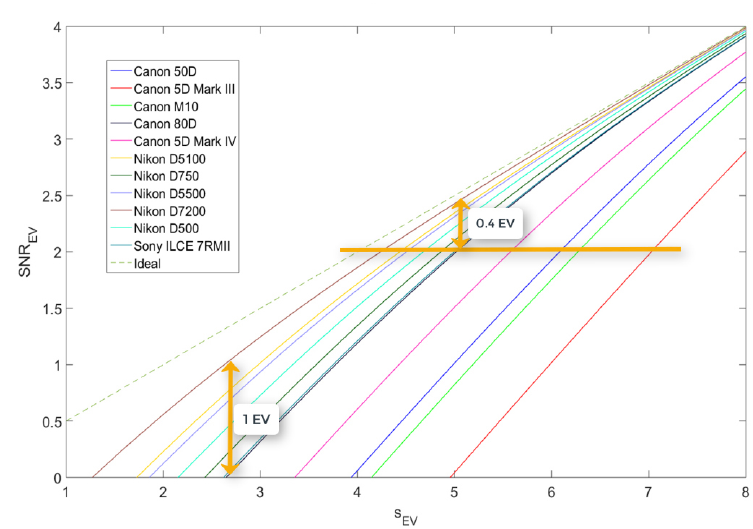
Figure 11. Comparison of pixel SNR for low signal values.